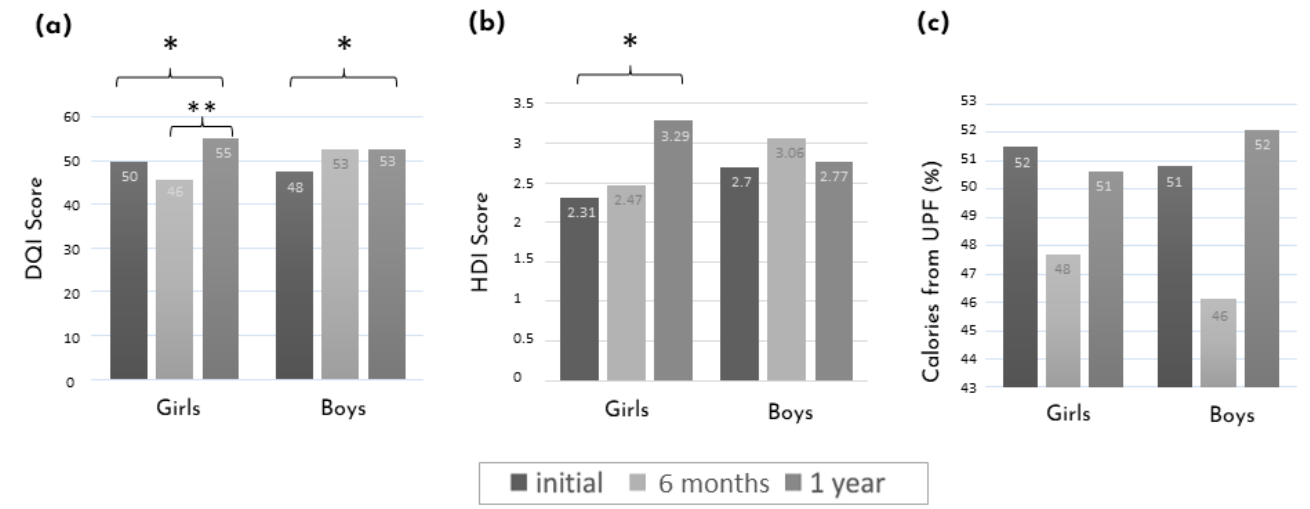
Figure 3. Mean diet score evolution between the initial assessment, after 6 months, and one year of intervention stratified by sex. ( a ) DQI score. ( b ) HDI score. ( c ) Calories from UPF (%). * p -value < 0.05 and ** p -value < 0.01 using the paired t-tests or Wilcoxon between time points. DQI: diet quality index; HDI: healthy diet index; UPF: ultra-processed foods.